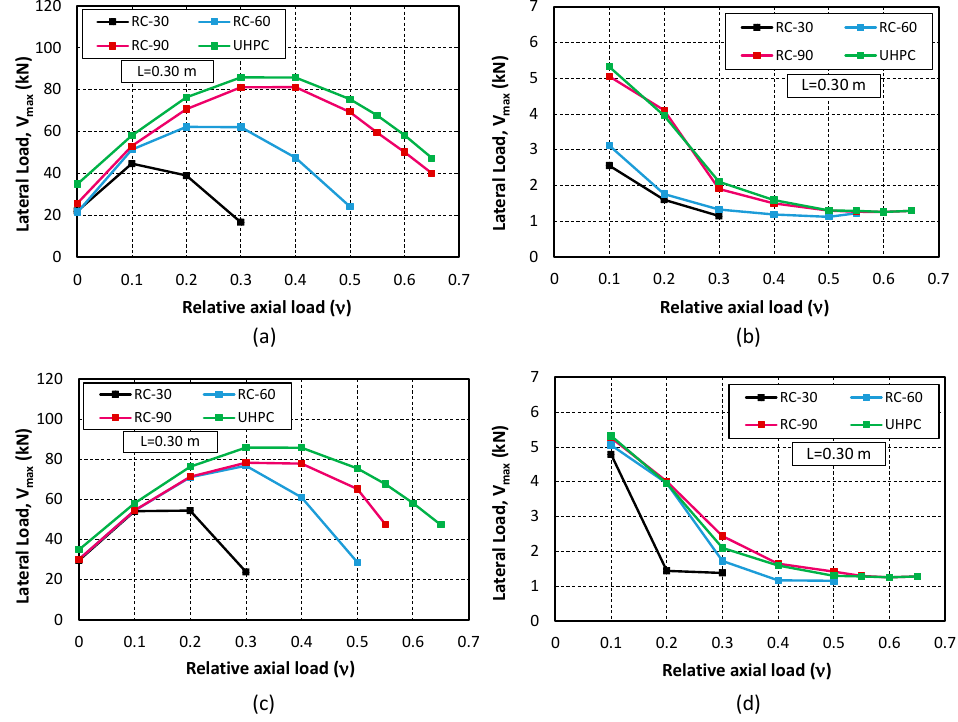
Figure 13. Maximum load and displacement ductility in the specimens made with UHPC–NiTi bars at the hybrid connection with no transition zone. Continuous joint (Phase 3): ( a ) lateral load–relative axial load for L = 0.3 m; ( b ) displacement ductility–relative axial load for L = 0.3 m; ( c ) lateral load–relative axial load for L = 0.6 m; ( d ) displacement ductility–relative axial load for L = 0.6 m.